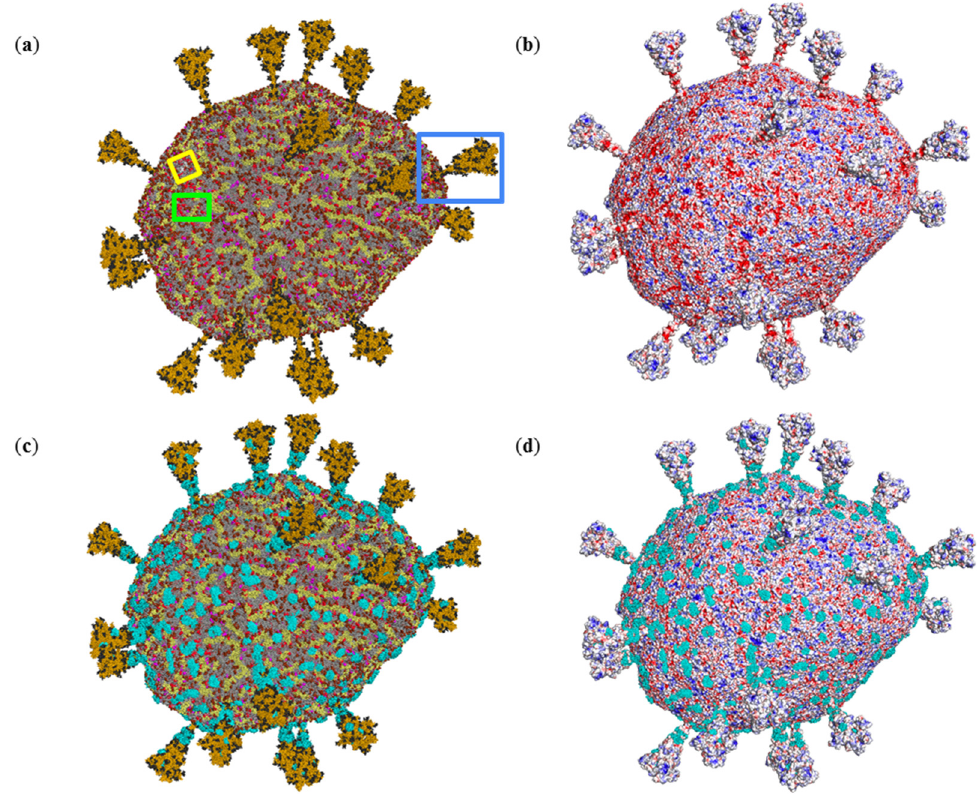
Figure 1. Three-dimensional structure of CG molecular model and electrostatic surface potential of SARS-CoV-2 virus envelope. CG beads colored in accordance with envelope component types ( a ). Rectangular boxes pick up the areas shown in Figures 2–4 (green, yellow and blue, respectively). Surface of the virion colored by electrostatic potential value from − 50 mV (red) to +50 mV (blue) ( b ). Electrostatic encounter complexes of ZnPcChol 8+ with SARS-CoV-2 virion obtained by BD ( c , d ). The virion is colored in accordance with the envelope component types ( c ) and electrostatic potential ( d ). CG beads of neutral lipids, namely POPC, POPE and CHOL, are shown in gray; CG beads of negatively charged lipids are shown in shades of red: POPI molecules—in brown; POPS—in magenta; CDL2—in red. M proteins are shown in pale yellow: E proteins—in white; S proteins—in mustard with black glycans. ZnPcChol 8+ molecules are visualized as cyan